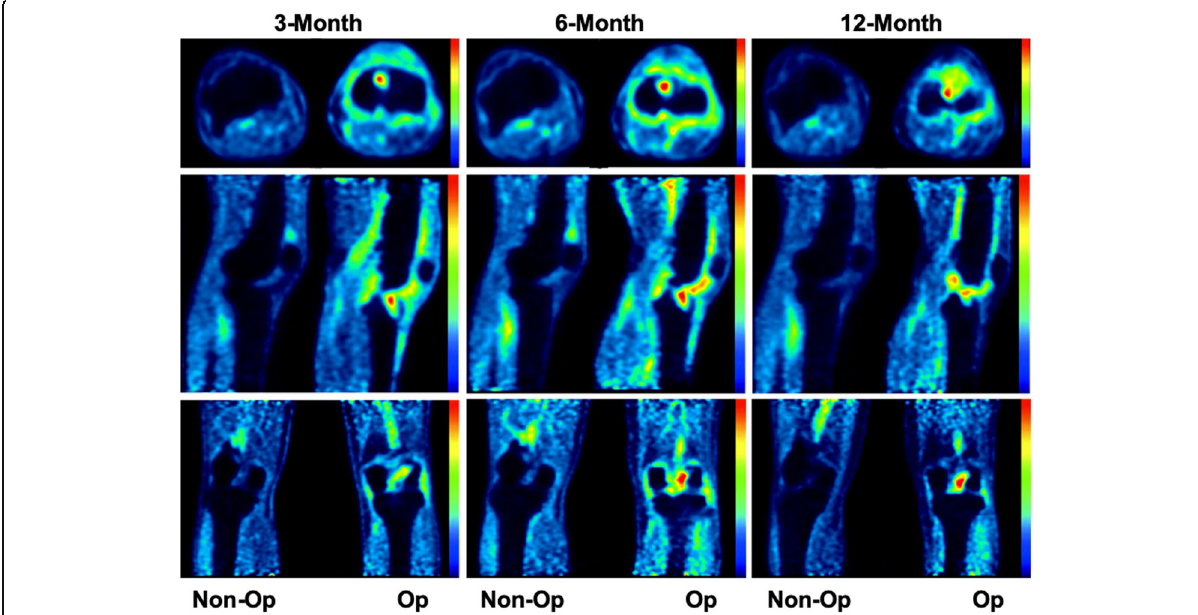
Fig. 1 Time course of PET uptake following ACL reconstruction. Whole knee PET uptake regions of interest in non-operative (left) and operative (right) knees 3 months, 6 months, and 12 months post-operatively from a single representative patient. Images are taken from axial (top), sagittal (middle), and coronal (bottom) planes centered on the ACL. Increased 18 F-FDG uptake is indicated by a shift from blue to